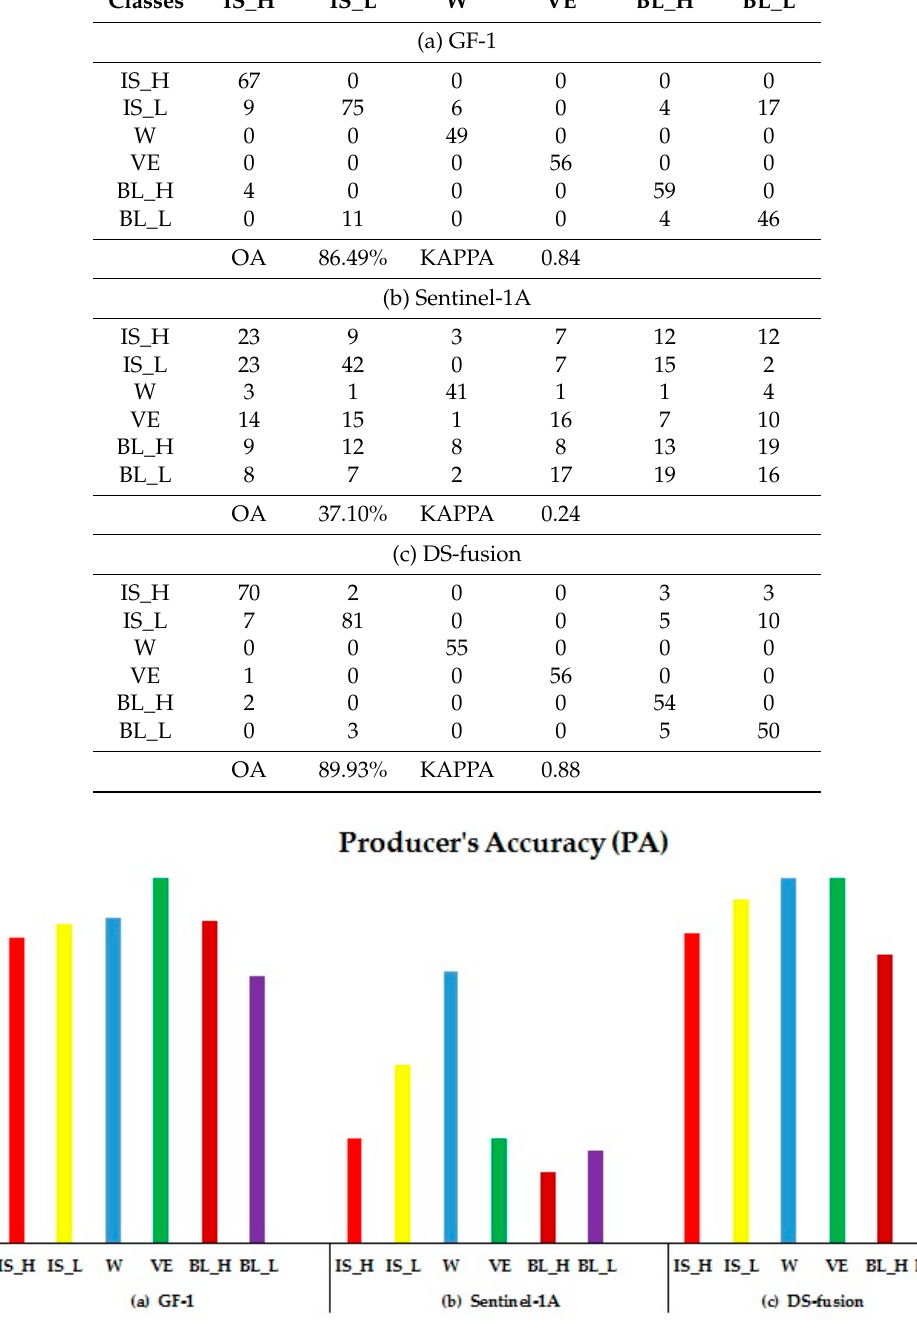
Figure 7. The producer’s accuracy of land cover types extracted from different data sources. ( a ) The producer’s accuracy of land cover types extracted from GF-1 image; ( b ) The producer’s accuracy of land cover types extracted from Sentinel-1A image; ( c ) The producer’s accuracy of land cover types extracted from fusing the GF-1 and Sentinel-1A image.